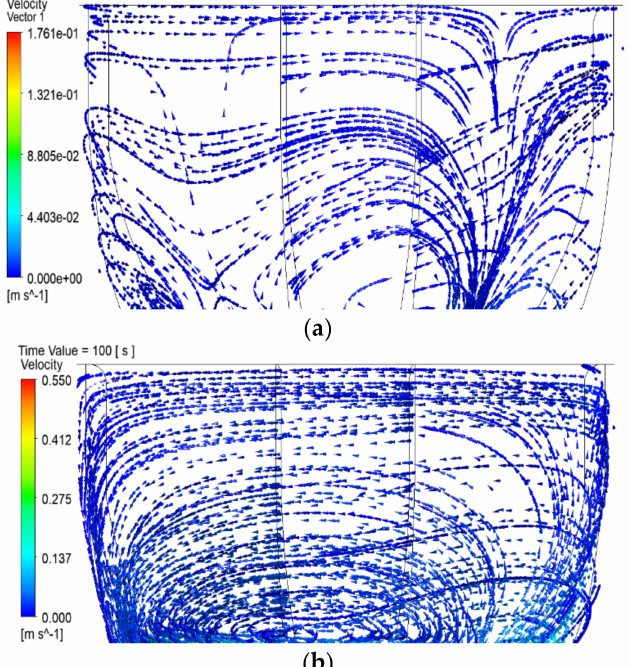
Figure 19. Detailed streamline side view of 10 W and 20 W with VF = 30%. ( a ) Streamline side view at VF = 30%, Q = 10 W. ( b ) Streamline side view at VF = 30%, Q = 20